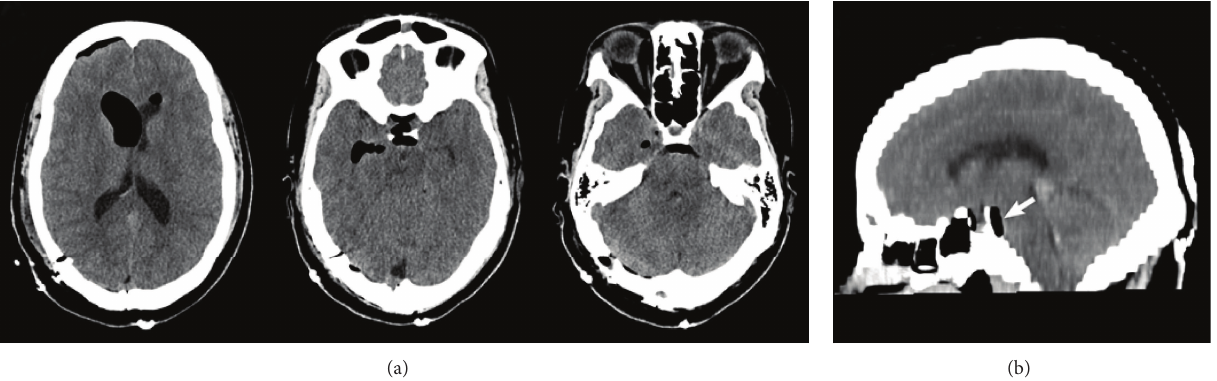
Figure 2: Immediate postoperative CT scan. Postoperative changes following resection of pineal region cystic lesion are evident in conjunction with significant pneumocephalus. Intracranial air is seen diffusely in the subarachnoid and ventricular spaces (a). A significant amount of air is also noted in the interpeduncular and prepontine cisterns. The midsagittal reconstructed image highlights the interpeduncular air (arrow; (b)).